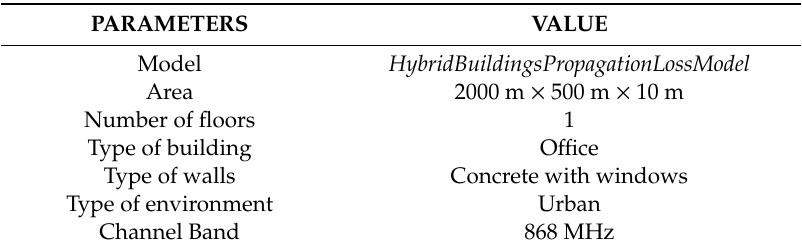
Table 5. Channel model